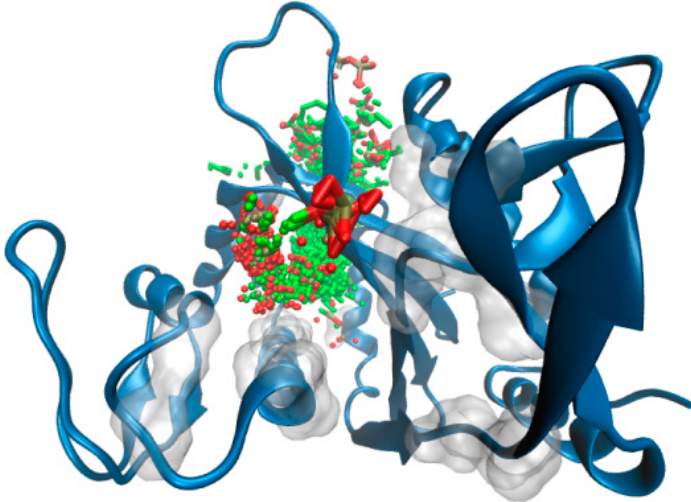
Figure 5. SwissDock binding predictions. The full set of octaprenyl pyrophosphate docking poses are shown in sticks at the binding pocket. Transparent surface is used to pinpoint residues that define the binding cavity. Δ TM-FlmC is rendered in blue cartoons.